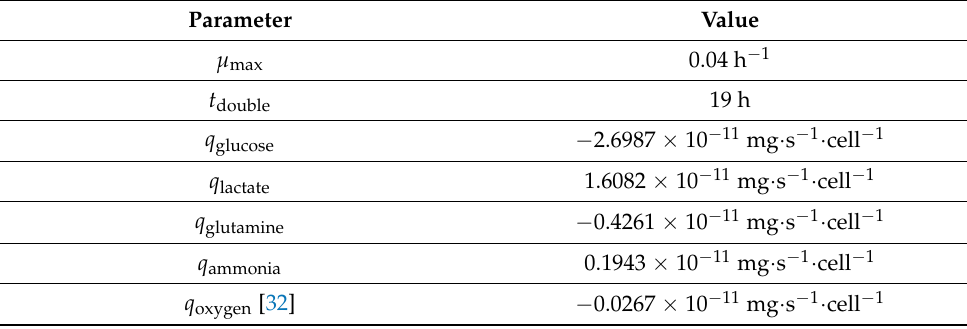
Figure 5. Growth kinetics of 1.1B4 β -cells (bottom chart), with corresponding concentrations of glucose and glutamine and their metabolites. Data are mean values ± SD ( n = 3). Table 3. Summary of cell-specific growth data based on the consumption and production rates of 1.1B4 β -cells during the exponential growth phase. The value for cell-specific oxygen consumption is an average reported for human promyelocytic leukemia (HL60) cells